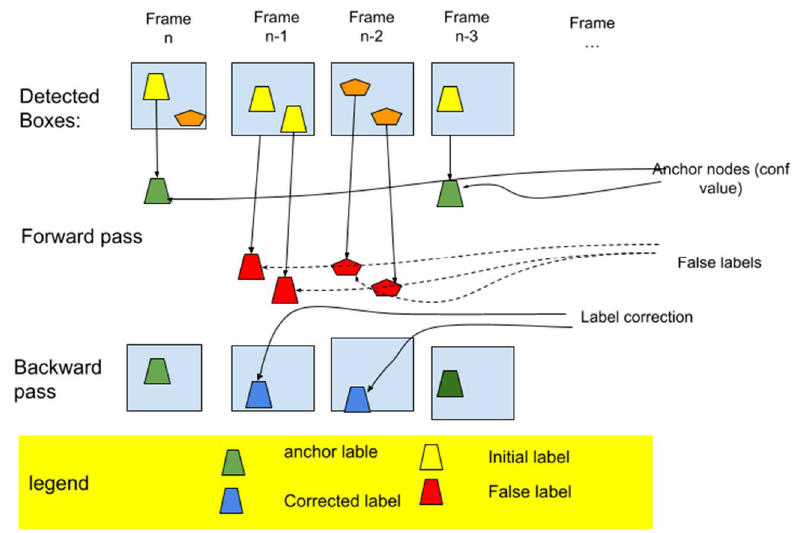
Figure 5. Flowchart of the filtering algorithm. Colored geometric shapes represent detected objects and their confidence levels. Forward pass: the filter algorithm uses the high confidence objects to change the labels of the mislabeled objects. Backward pass: relabeling using additional anchor boxes.